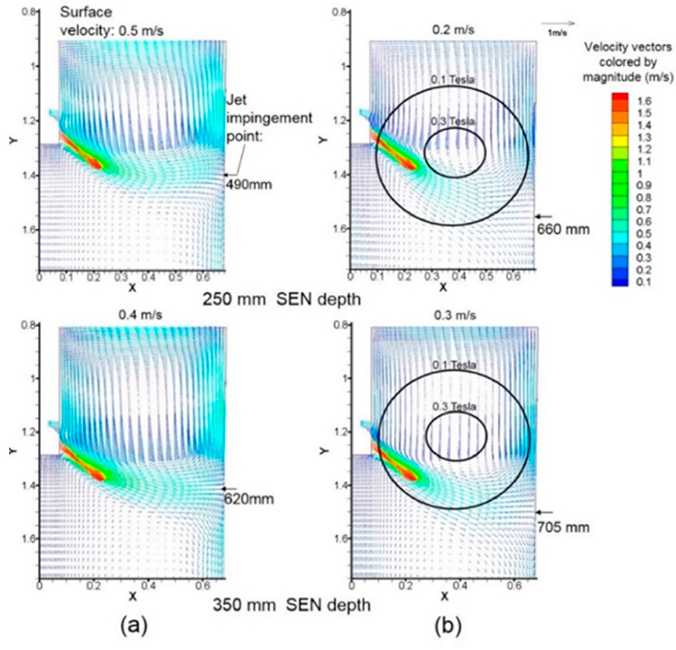
Figure 10. Mold flow pattern ( a ) without and ( b ) with local EMBr [61].